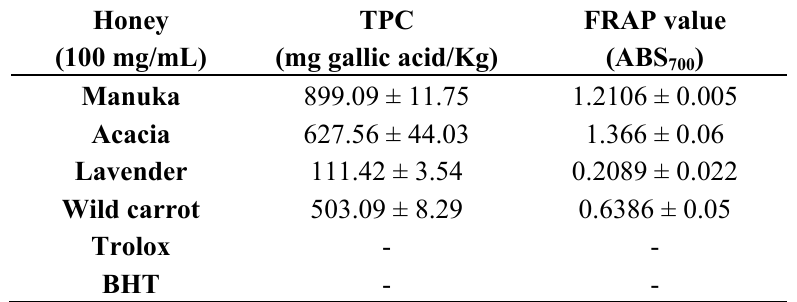
Table 2. Phenol content (mg gallic acid/kg) and FRAP values of tested